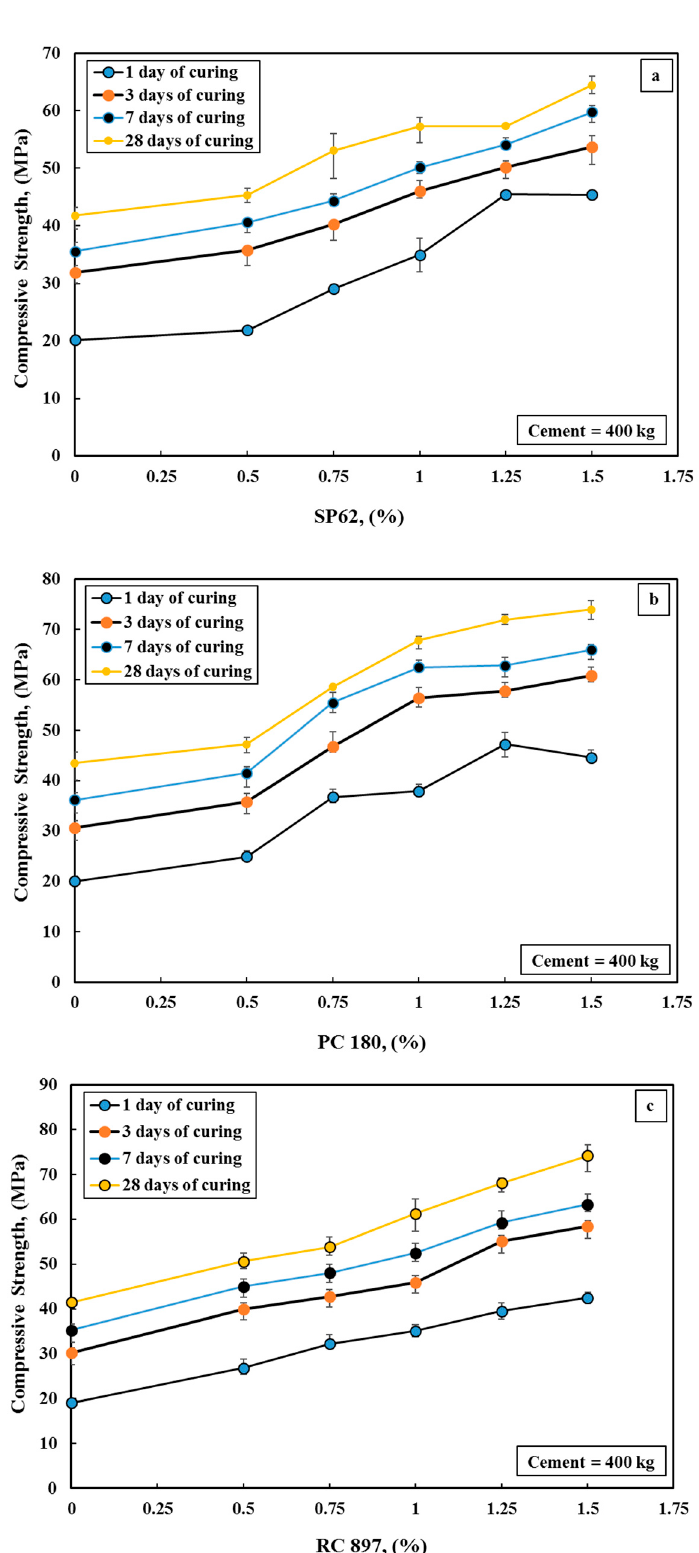
Figure 4. Additives’ impact the concrete compressive strength using 350 kg of cement ( a ) SP62, ( b ) PC 180, and ( c ) RC 897.